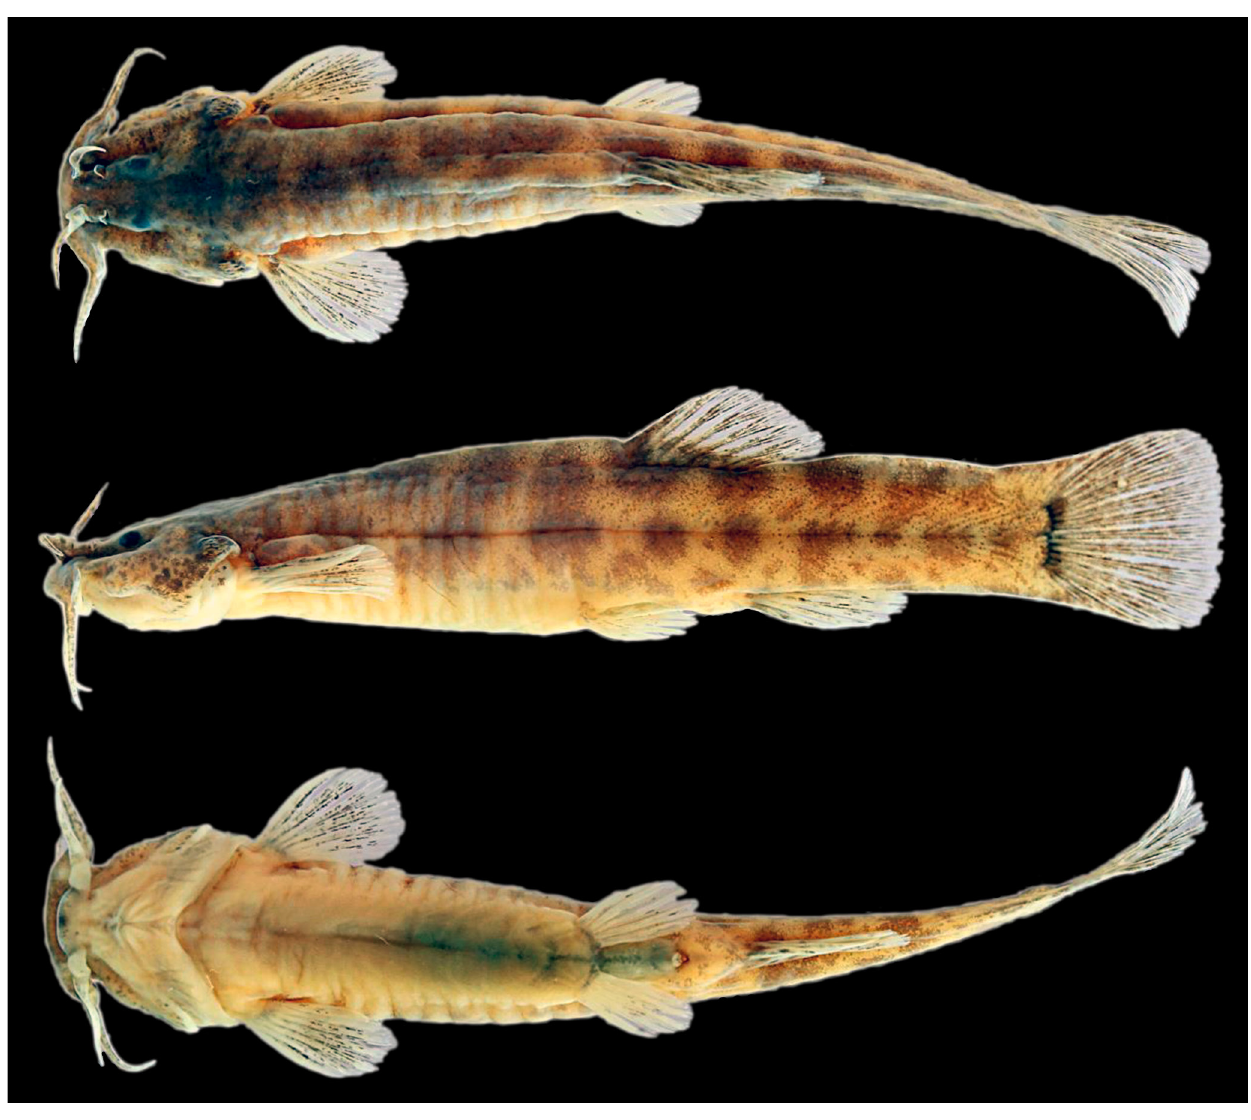
FIGURE 8 | Scleronema ibirapuita , new species, holotype (MCN 19470; 39.5 mm SL), Brazil, Rio Grande do Sul, Santana do Livramento,